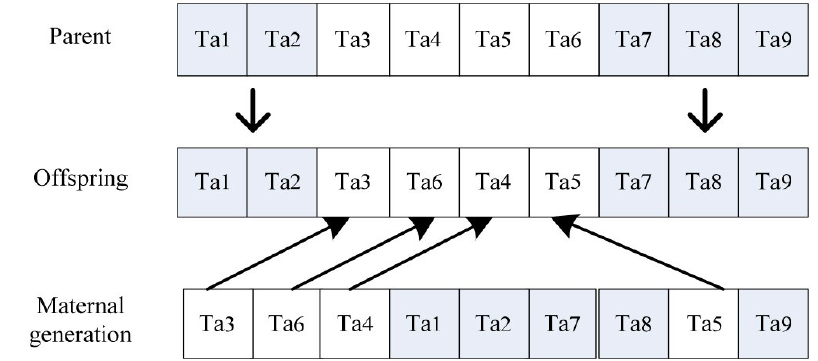
Figure 2. Double point